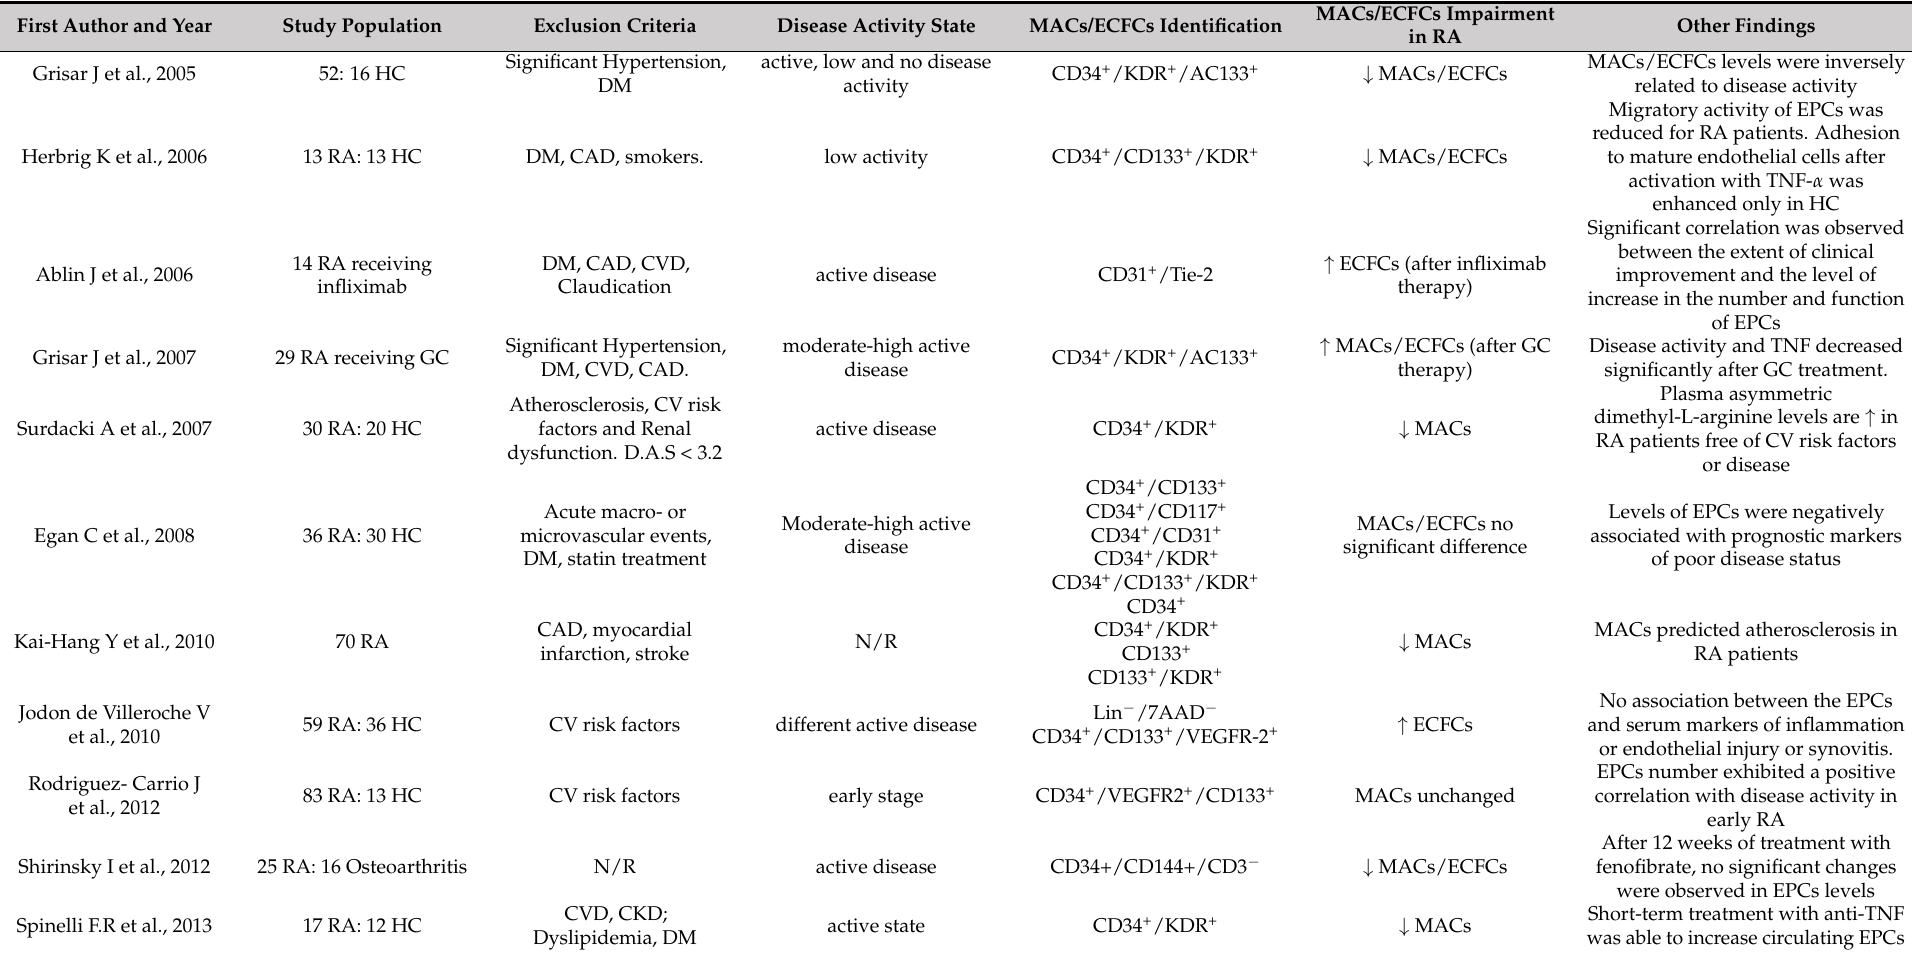
Table 1. Endothelial Progenitor Cells in Rheumatoid Arthritis